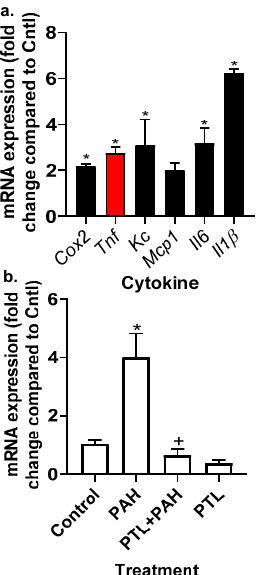
Figure 7. Inflammatory mediator gene expression was elevated in the MHS cells in response to the LMW PAH mixture. ( a ) In response to the 20 μ M LMW PAH mixture (1:1 ratio of 1-methylanthracene and fluoranthene), Cox2 , Tnf , Kc , Mcp1 , Il6, and Il1 β were all significantly elevated (* p < 0.05) compared to controls (DMSO) cells following 4 h of treatment in the MHS cells. mRNA for each cytokine gene was normalized to 18S and then fold change determined compared to control. Cox2, cyclooxygenase 2; Mcp1, monocyte chemo-attractant protein 1; IL6, interleukin 6. Tnf (red bar) indicates the cytokine we used for the recombinant cytokine studies that follow. ( b ) PTL inhibits Tnf expression in response to PAH exposure. * p < 0.05 PAH compared to control; + p < 0.05 PTL + PAH compared to PAH treatment. Experiments repeated 2–3 times with an n = 3 per experiment. Table 1. MHS cell inflammatory cytokines/chemokine response following 4 h treatment with the binary PAH mixture.